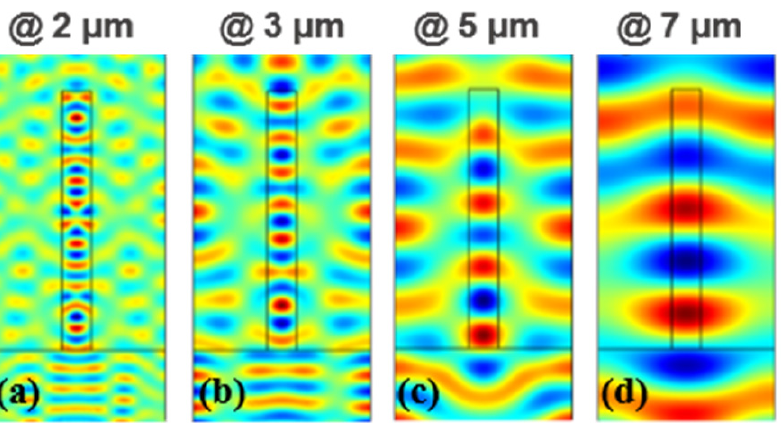
Figure 5. Spatial distribution of the magnetic field ( H y ) at the wavelength of ( a ) 2 µ m, ( b ) 3 µ m, ( c ) 5 µ m, ( d ) 7 µ m. Red and blue represent the maximum and minimum magnitudes, respectively. When the wavelength of the incident light is increased but is less than 7 µ m, the extinction coefficient ( k ) of silica is silica is no longer transparent, but its absorption loss is low (the extinction coefficient is less than 0.02) [31]. In many optical systems, the loss of materials with extinction coefficient less than 0.02 can be neglected. However, the thickness of the silica layer (h s ) is very large in our structure (100 µ m), thus, the extremely small extinction coefficient cannot be ignored. In Figure 5c,d, the magnetic fields at different wavelengths in this region are plotted. The longitude guided modes still exist in the grating and the silica substrate at these wavelengths. The absorption/emissivity of the grating structure and the no-grating structure in the range of 3.5–8 µ m are plotted in Figure 6b. Unlike the absorption spectrum in the solar wavelength, the absorption here shows a near-unit absorption in some wavebands. Additionally, the two absorption spectra almost coincide. These results indicate that the high absorption/emissivity in the region 4–7 µ m